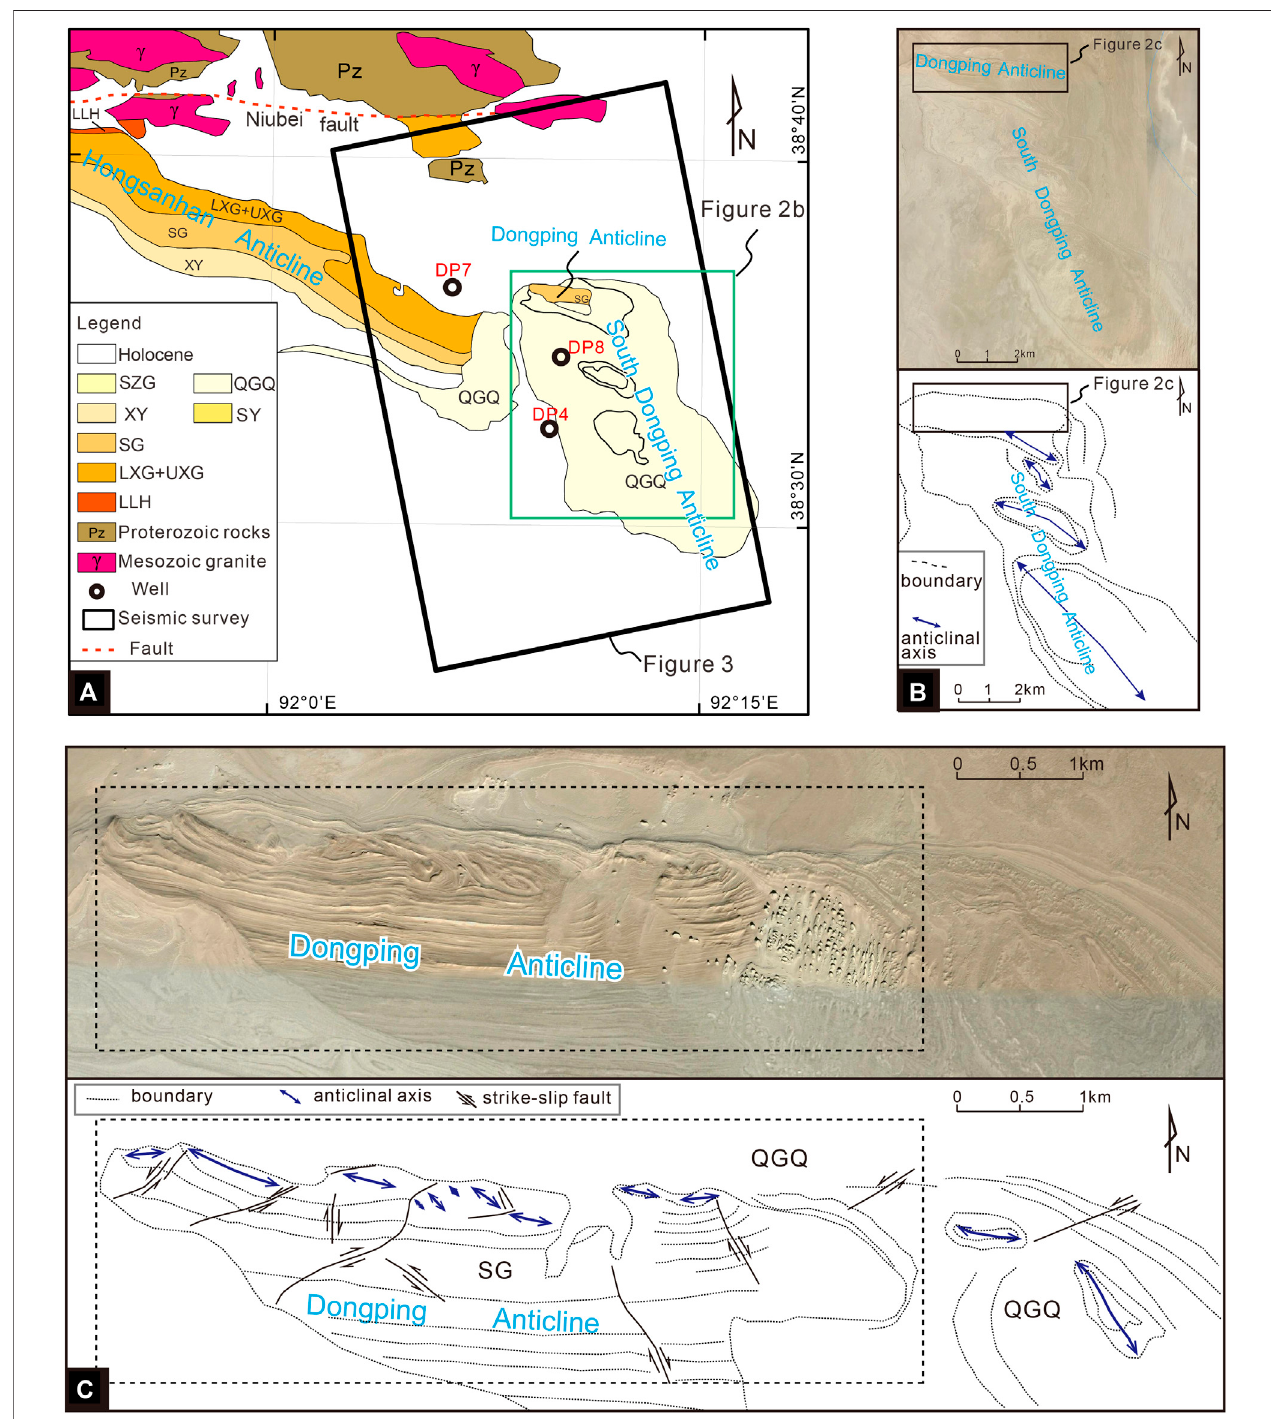
FIGURE 2 | (A) Geological map of Dongping area. (B) Remote sensing images showing surface deformation: a group of NNW-oriented dextral transpressional anticlines in the south and an E-W-striking sinistral transpressional belt in the north. (C) Zoom-in of the sinistral transpressional belt, showing a series of en echelon anticlines and minor strike-slip faults. The interpretation within the dotted rectangle is modi fi ed from Wu et al. (2019). Abbreviations for the Cenozoic units are same as those in Table 1 .